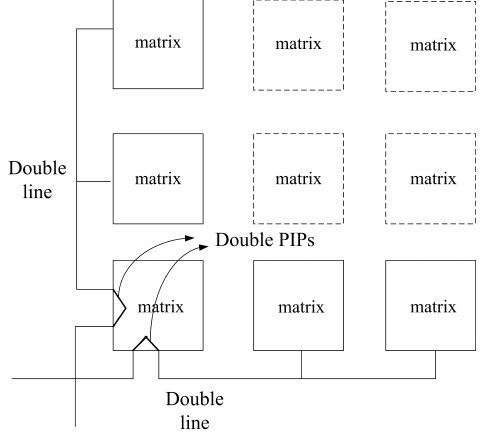
Figure 2. Single lines and single programmable interconnect points (PIPs).